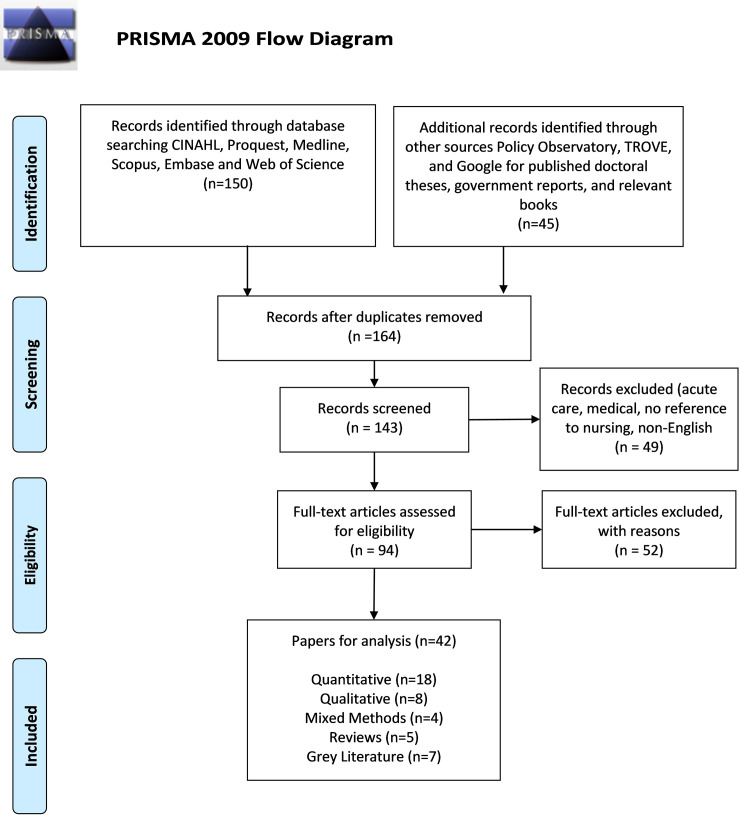
PRISMA flowchart.